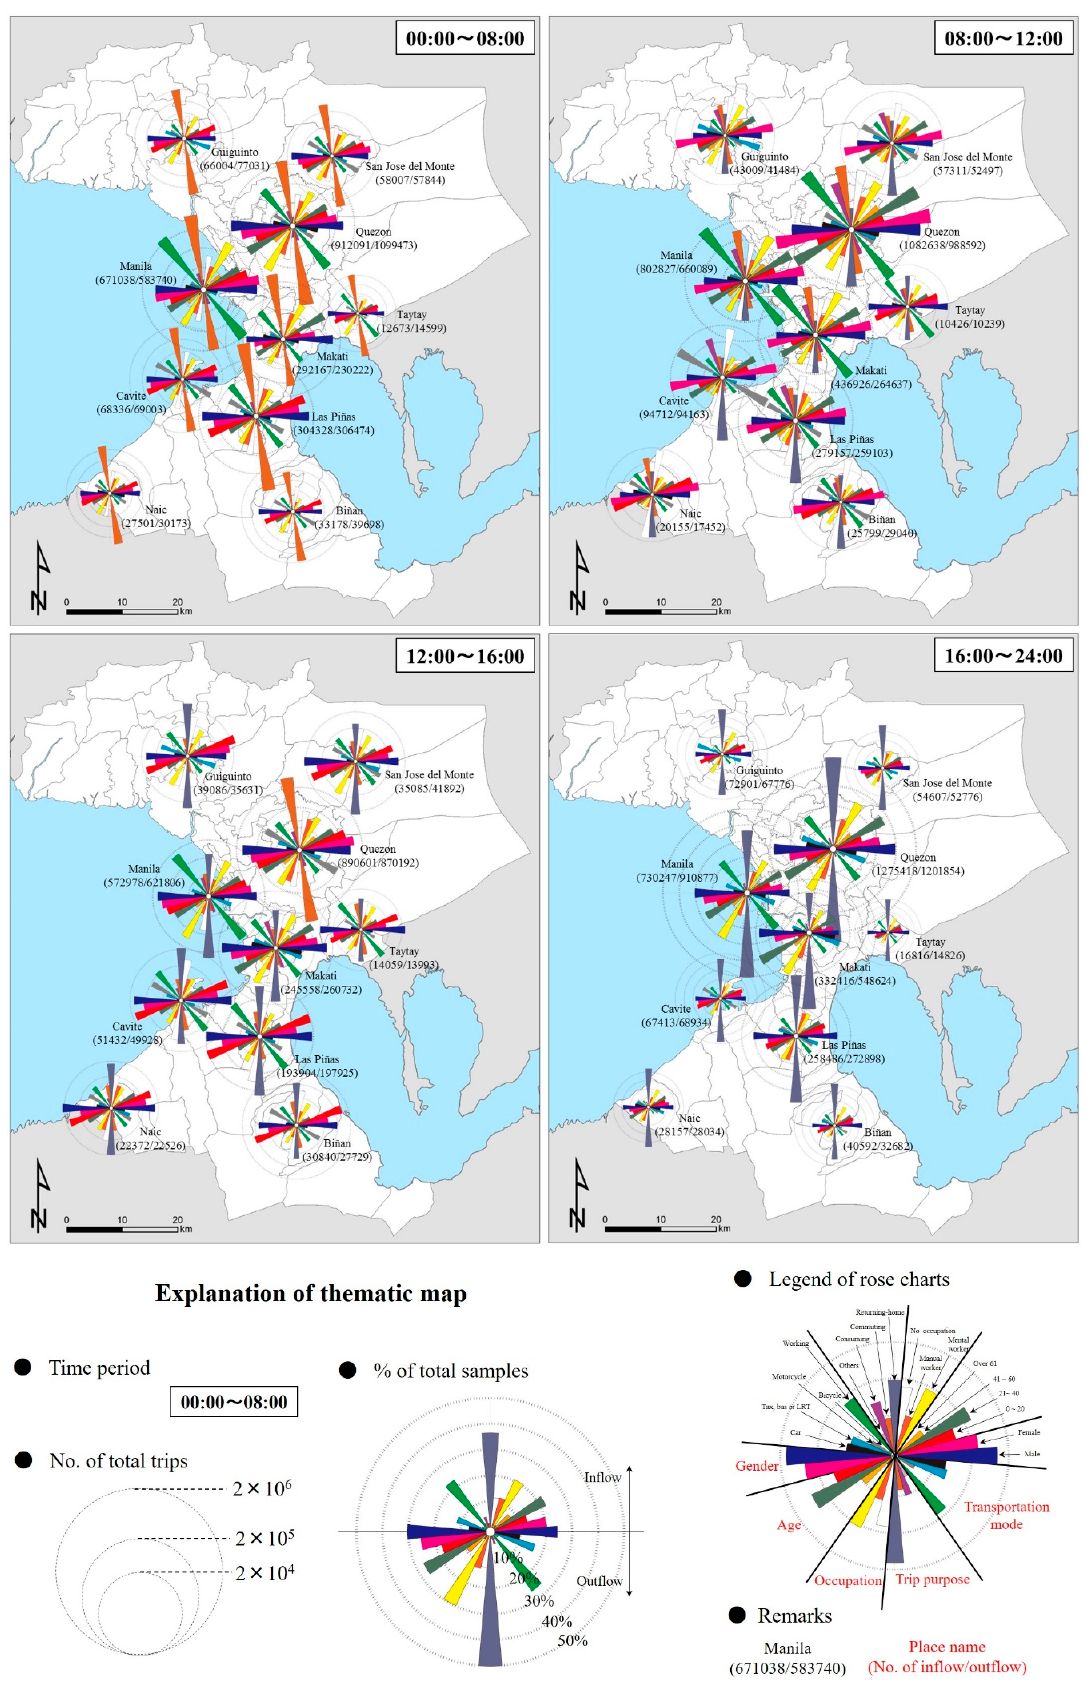
Figure 8. Temporal pattern of human mobility in Manila metropolitan area based on different properties.